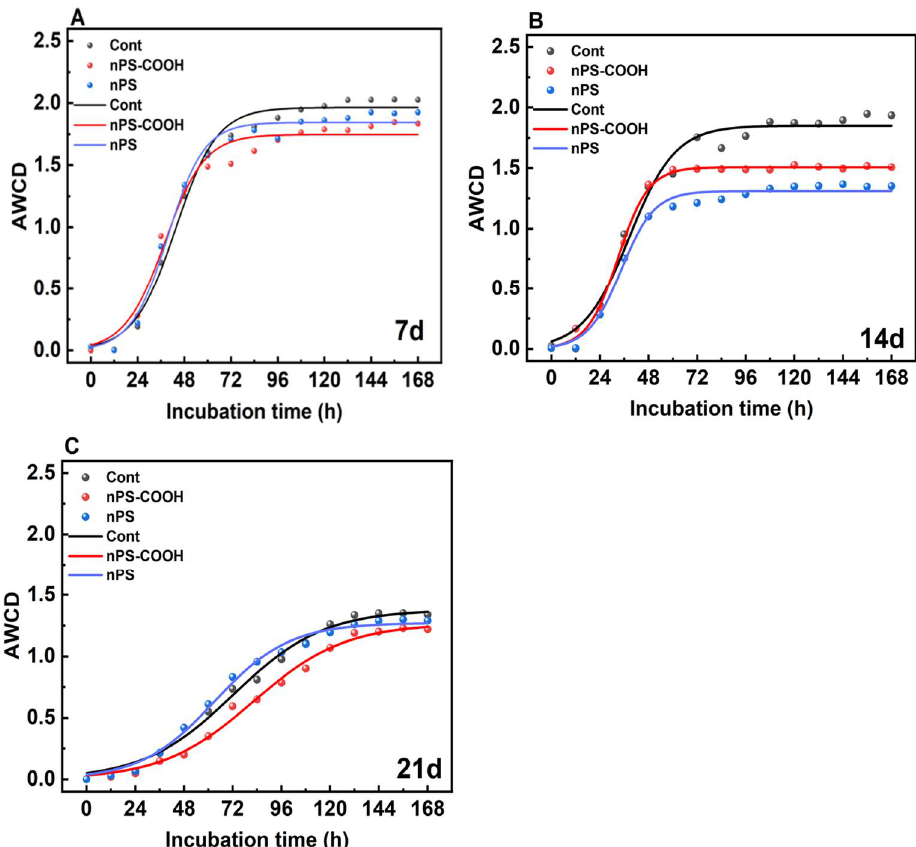
Figure 1. Comparison of carbon metabolic capacity of biofilms exposed to PS NPs with different surface modifications (nPS and nPS-COOH) at day 7 ( A ), day 14 ( B ), and day 21 ( C ) ( n = 3).